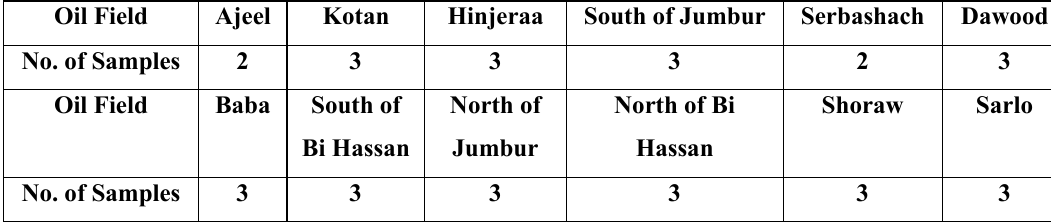
Table 1: Sludge samples which were collected from each oil field which lies in north region of Iraq.